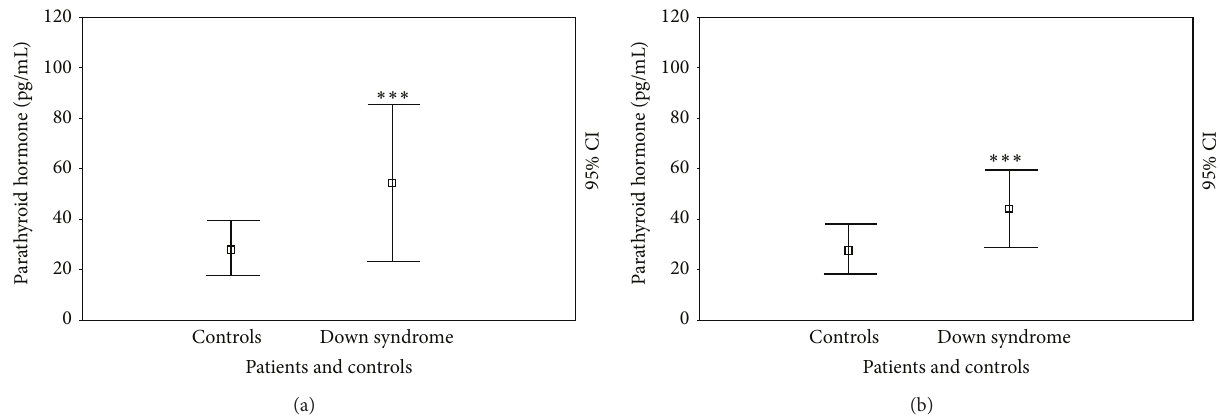
Figure 5: Parathyroid hormone levels (ng/mL) at cross-sectional (a) and longitudinal (b) evaluation in patients with Down syndrome and controls. ∗ 𝑃 < 0.05 ; ∗∗ 𝑃 < 0.005 ; ∗∗∗ 𝑃 < 0.001 .